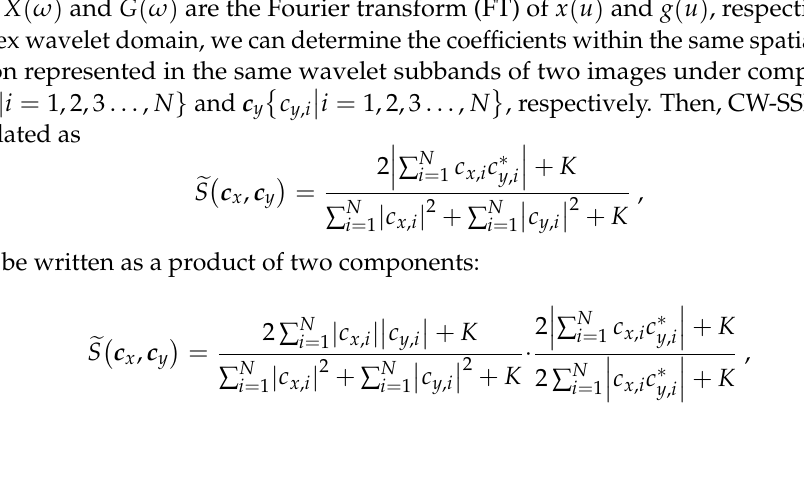
pixel image, ( c ) smooth pixel image, and ( d ) texture pixel image.